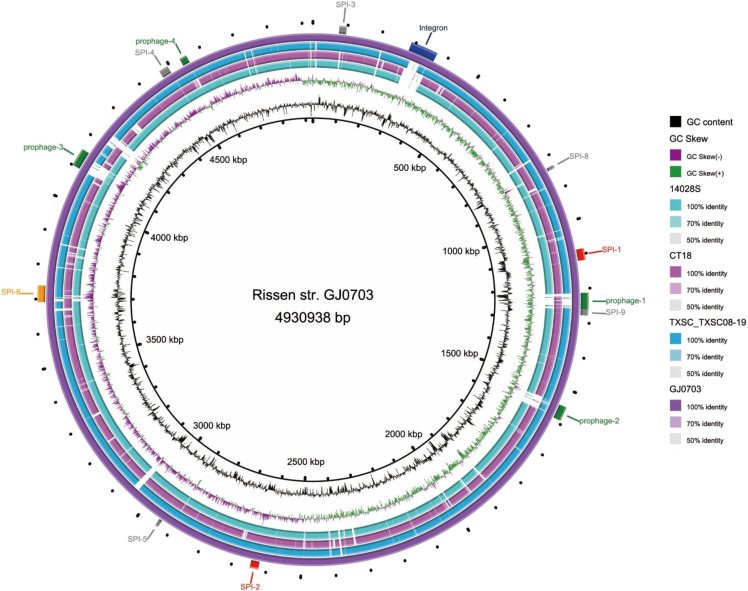
Circular schematics of the S. Rissen GJ0703 genome. From inner to outer circles: GC content, GC skew, homologs in strain 14028S, homologs in CT18, homologs in strain TXSC_TXSC08-19 and mobile genetic elements identified using VRprofile. Customized CGview and VRprofile analyses were performed using the S. Rissen genome to generate circular comparisons. The predicted Salmonella Pathogenicity Island (SPI) genes and other virulence determinants are respectively indicated and drawn to scale.